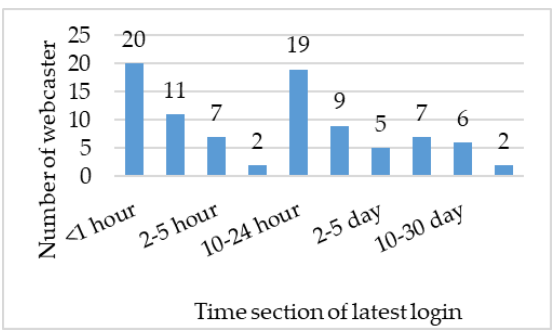
Figure 20. Time distribution for the 88 webcasters’ latest login on the YY mobile app.